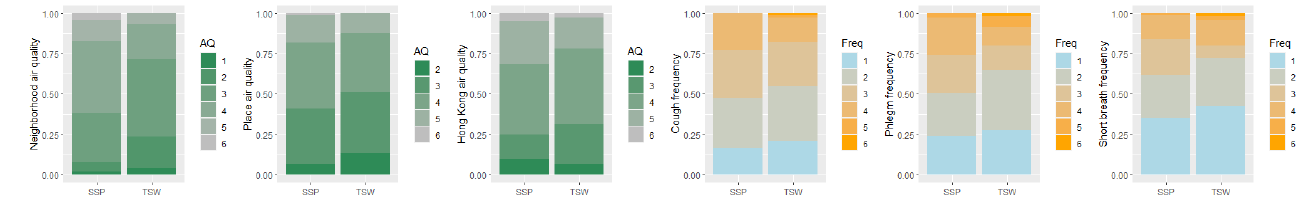
Figure 2. Distribution of participants’ perceived air quality and their self-reported respiratory symp- toms regarding different socio-demographic axes: ( a ). gender, ( b ). age, ( c ). monthly household in- come, ( d ). education level, and ( e ). marital status. AQ is short for air quality.